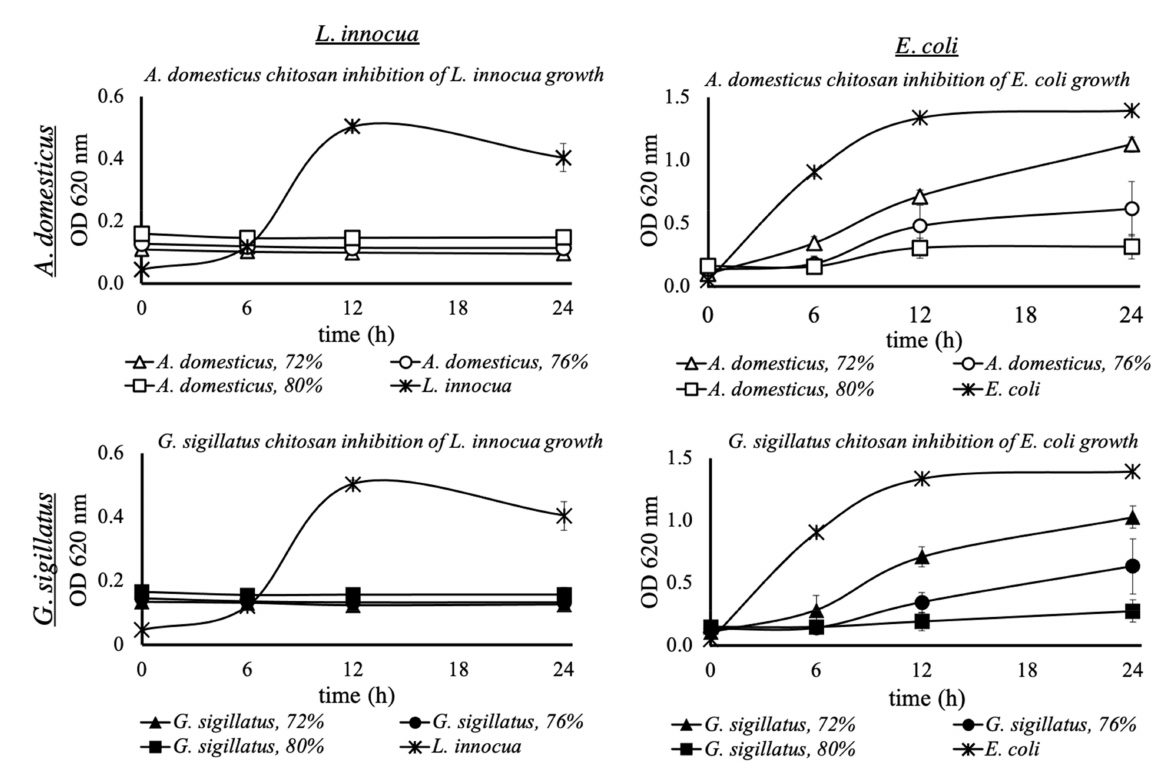
Figure 3. Antimicrobial effect of chitosan from edible A. domesticus (empty shapes) and G. sigillatus (filled shapes) crickets, with varying degrees of deacetylation including 72% (triangles), 76% (circles) and 80% (squares), on the growth of Listeria innocua (left column) and Escherichia coli (right column) over 24 h of incubation (37 ◦ C). Table 4. Effect of edible cricket chitosan (0.50 mg/mL) with varying degrees of deacetylation on bacteria growth inhibition (%) after 24 h incubation.